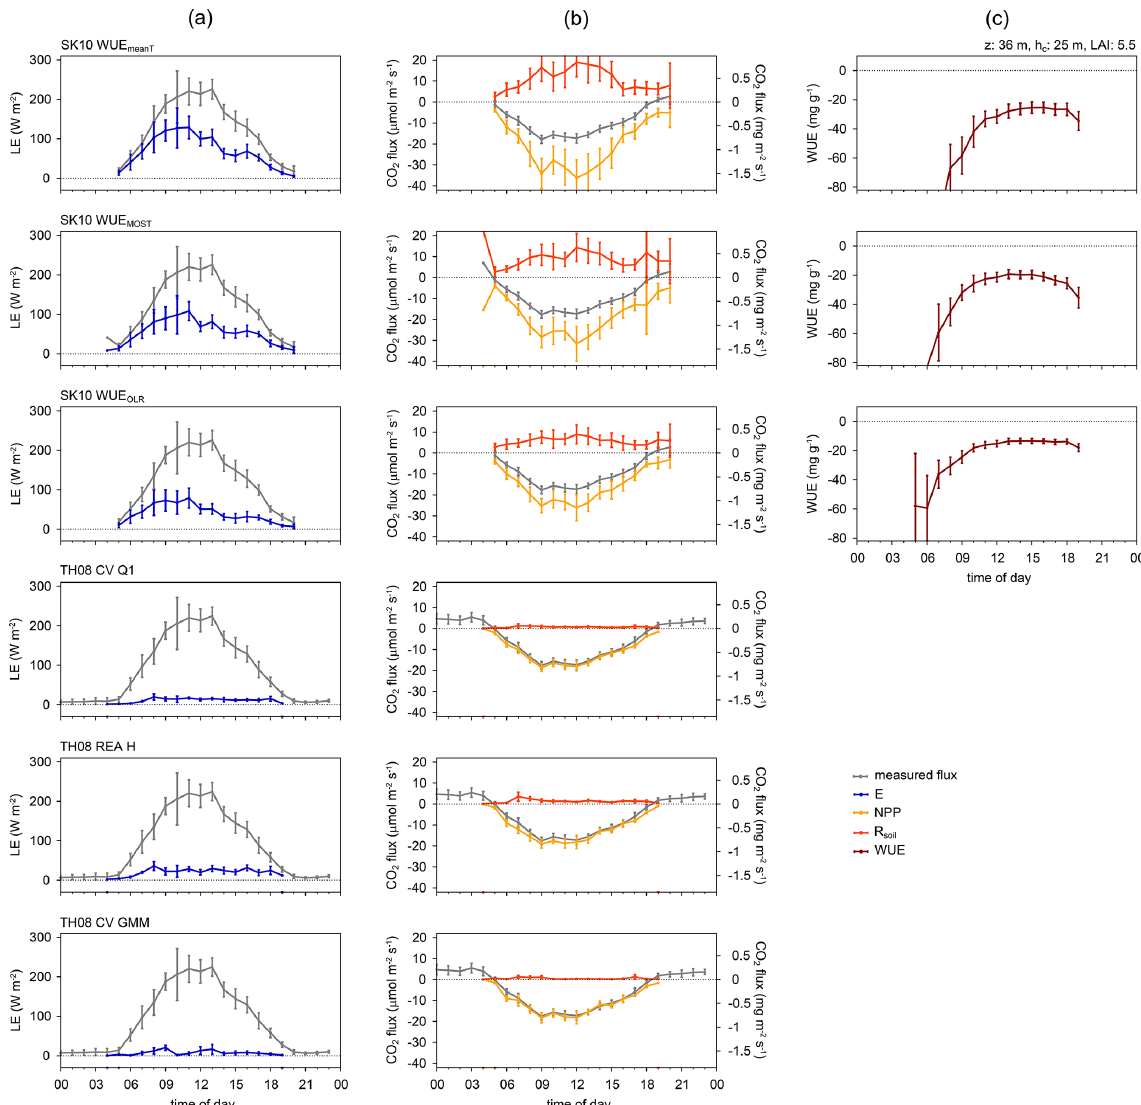
Figure 3. Diurnal dynamics of source partitioning results for (a) H 2 O and (b) CO 2 fluxes and ( c ) water use efficiency (WUE) for the Waldstein study site (forest) in Germany for 4–10 July 2016 and for selected method versions (see text for description; LE: latent heat flux; E : evaporation; NPP: net primary production; R soil : soil respiration; z : measurement height; h c : canopy height; LAI: leaf area index). Error bars indicate the 95% confidence intervals of the mean